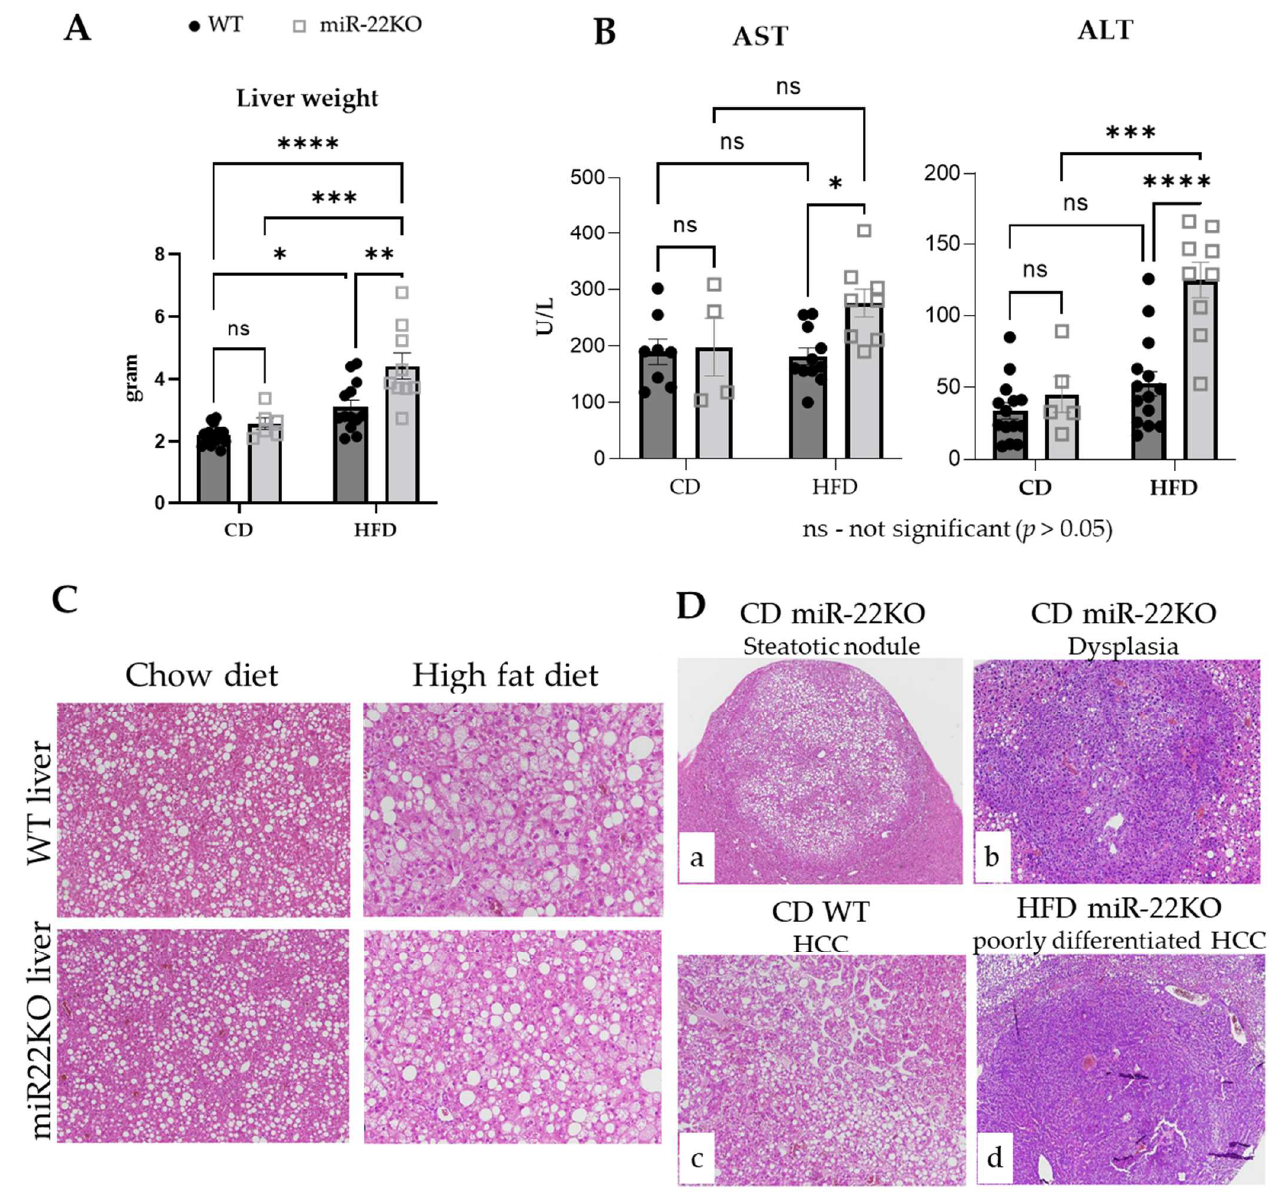
Figure 3. Ex vivo and histological analysis of livers and tumors of miR-22KO and WT mice. ( A ) Liver weight ( n = 6–14/group), ( B ) plasmatic aspartate aminotransferase (AST, n = 4–11/group) and alanine aminotransferase (ALT, n = 5–14/group) levels of miR-22KO mice and WT littermates under standard chow diet (CD) or high-fat diet (HFD), at time of sacrifice. Data are represented as mean +/− SEM. Two-way ANOVA (multiple comparisons) were performed. p -values are represented as follows: * p ≤ 0.05; ** p ≤ 0.01; *** p ≤ 0.001; **** p ≤ 0.0001. ( C ) Representative H&E-stained histological images of non-tumoral livers of WT and miR-22KO mice under CD (magnification ×10) and HFD (magnification ×20). ( D ) Representative histological images of tumors with H&E staining (( a )—Steatotic nodule in a miR-22KO mouse under CD, magnification ×4; ( b )—Dysplasia in a miR-22KO mouse under CD, magnification ×10; ( c )—HCC in a WT mouse under CD, magnification ×10; ( d )—poorly differentiated HCC in a miR-22KO mouse under HFD, magnification ×4).